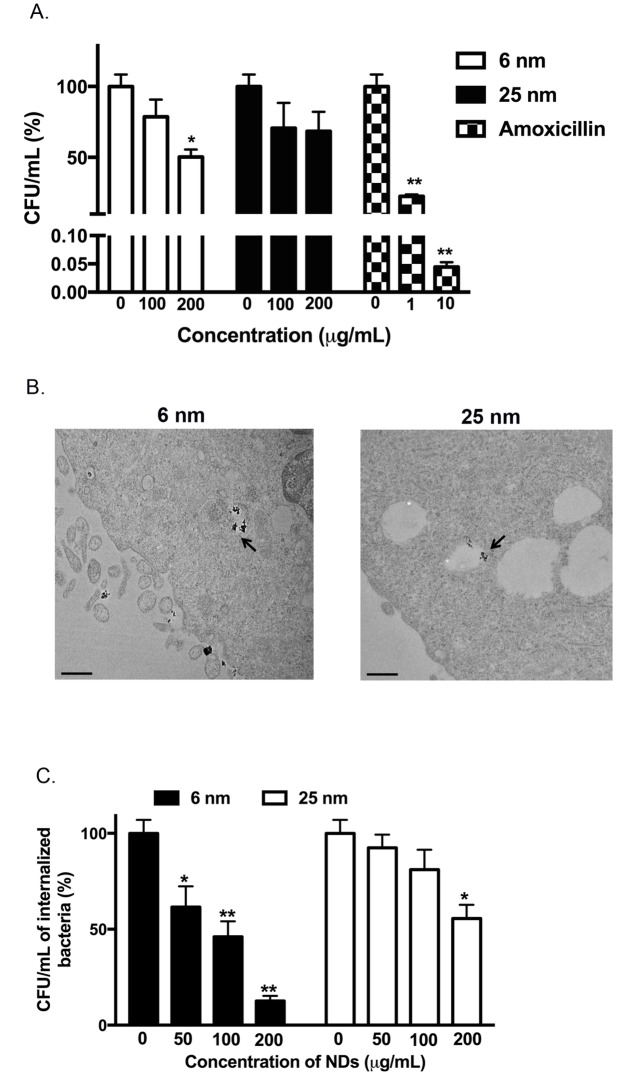
Acid-treated 6 nm NDs can kill extracellular and intracellular E. coli.(A) E. coli was treated with different concentrations of acid treated 6 nm or 25 nm NDs. Treatment with amoxicillin was used as a positive control. Following incubations, the samples were plated on sterile Luria agar and the colony forming units (CFU)/mL were enumerated. The CFU/mL for the 0 μg/mL sample was determined 100%. The CFU/mL counts for ND treated samples were determined relative to the 0 μg/mL sample. Data is represented as mean ± SEM. *P<0.001, **P<0.0001 vs 0 μg/mL was determined by one-way ANOVA followed by Tukey’s multiple comparisons test. (B) T24 cells were treated with 6 nm or 25 nm acid-treated NDs for 4 hours and analyzed by TEM. NDs are indicated by arrows. Scale bar = 500 nm. (C) T24 cells were infected with E. coli, followed by treatment with gentamicin to kill extracellular bacteria. Following gentamicin treatment, the infected T24 cells were treated with 6 nm or 25 nm acid treated NDs for 24 hours. The cells were then lysed and intracellular E. coli were enumerated. The CFU/mL for the 0 μg/mL sample was determined 100%. The CFU/mL for ND treated samples were determined relative to the 0 μg/mL sample. Data are representative of at least three independent experiments and depicted as mean ± SEM. *P<0.01, **P<0.0001 compared to 0 μg/mL of the corresponding acid-treated ND was determined by two-way ANOVA followed by Tukey’s multiple comparisons test.